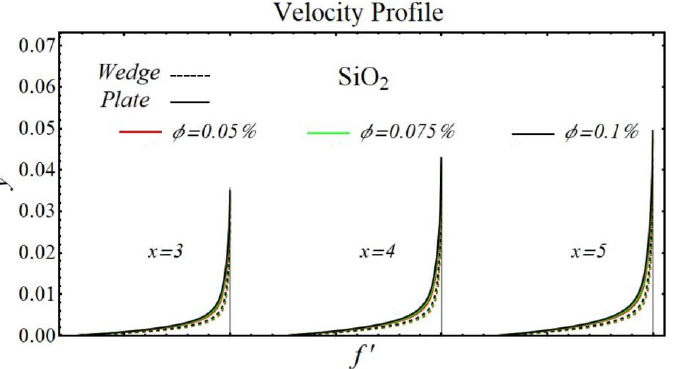
Figure 20. Velocity profile of SiO 2 /DIW nanofluids over the wedge and plate under the impact of nanoparticle volume fraction.